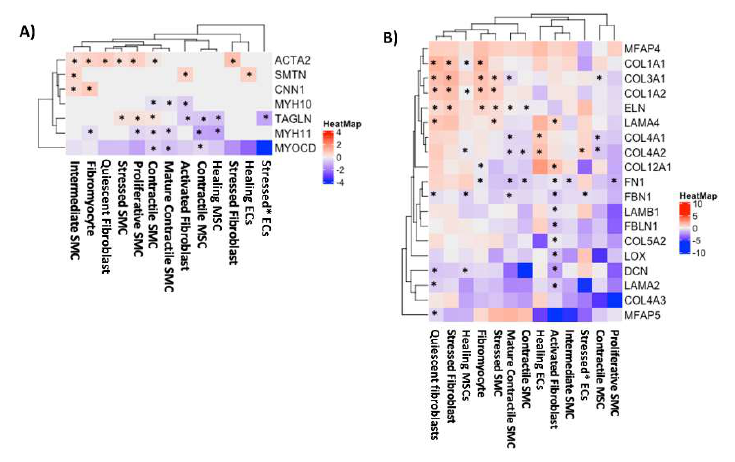
Figure 3. Decreased SMC differentiation in MFS compared to control. ( A ) Differential expression of contractile genes in non-immune cells in MFS compared to control tissues. ( B ) Differential expression of extracellular matrix structural genes in MFS compared to control tissues. Differential expression is visualized as log2FC with MFS compared to control. * Denotes clusters with significant differential expression (adjusted p < 0.05).